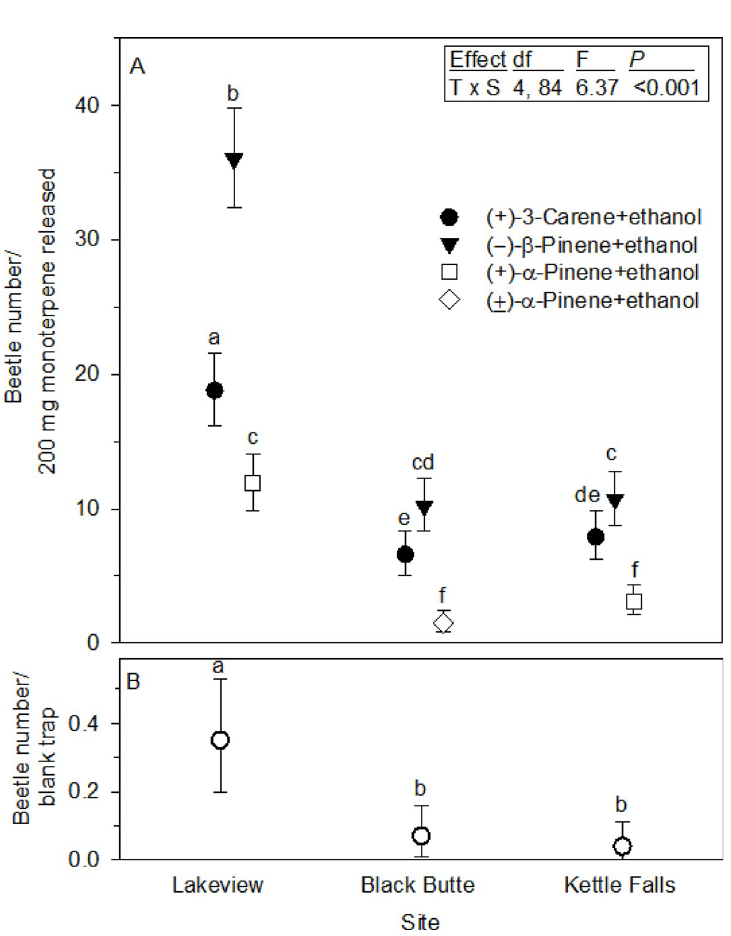
Fig 3. Number of Dendroctonus valens captured (mean ± 95% CIs). (A) Number/200 mg of monoterpene released/ trap ( n = 15) at each study site. Symbols with different letters indicate statistical differences at P � 0.024. Inserted box shows ANOVA table results with effects abbreviated; T = terpene, S = site. (B) Number/blank trap/day; Lakeview vs. Kettle Falls (t 42 = 4.04, P < 0.001), Lakeview vs. Black Butte (t 42 = 3.40, P = 0.001), and no differences between Kettle Falls and Black Butte (t 42 = 0.64, P = 0.526). Values in (A) and (B) are back-transformed geometric means and 95%